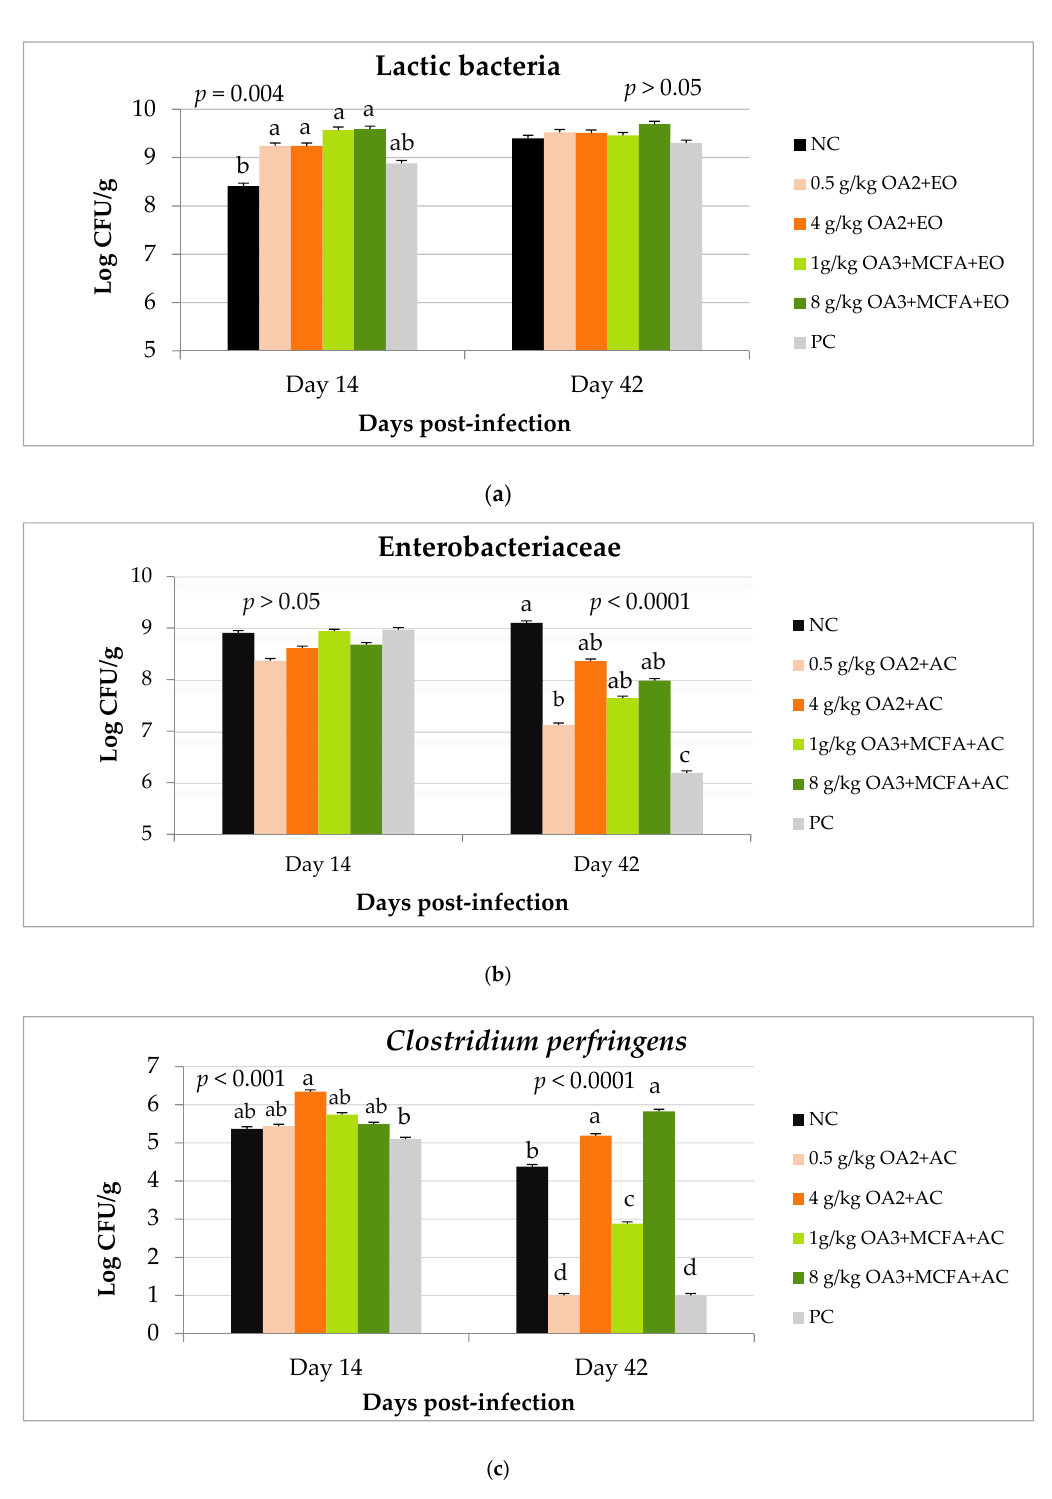
Figure 5. Effect of treatments on lactic bacteria ( a ), Enteribacteriaceae ( b ), and C.perfringens ( c ) count (log10 CFU) in feces collected on d 14 and 42 of age. OA2: Calcium butyrate + fumaric acid; OA3: Calcium butyrate + fumaric acid + citric acid + MCFA; MCFA: Capric-caprylic acid + caproic acid + lauric acid; AC: Cinnamaldehyde, carvacrol, and thymol as major compounds; NC: Negative control; PC: Positive control. a,b,c,d Means with different superscripts for the same day indicate significant difference between treatments ( p ≤ 0.05).